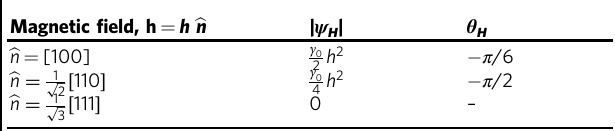
Table 2 Effective magnetic fi eld strengths | ψ H | and associated complex angle θ H Magnetic fi eld, h = h b